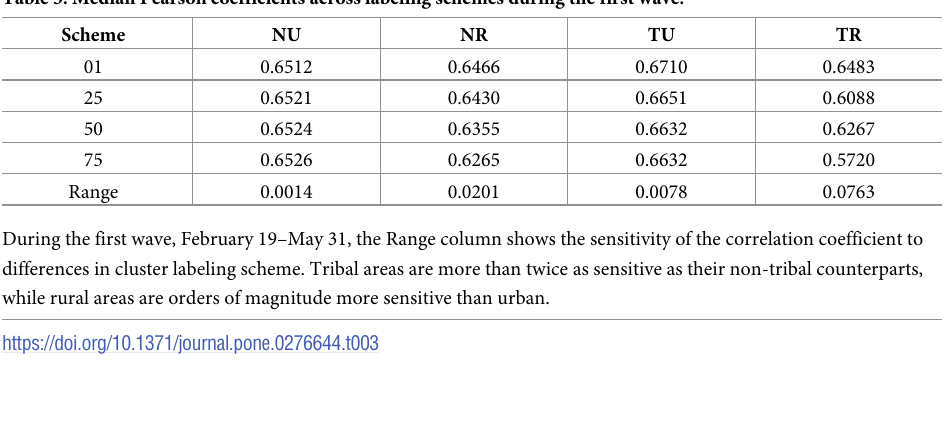
Table 3. Median Pearson coefficients across labeling schemes during the first